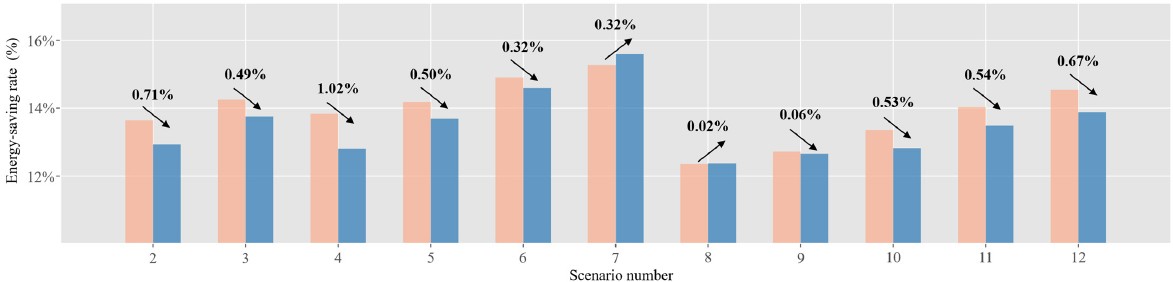
Figure 13. Comparison of energy-saving performance using different strategies in typical and corresponding similar scenarios (blue bars represent the fixed setpoint obtained from typical scenarios, orange bars represent the optimal setpoint obtained from similar scenarios).